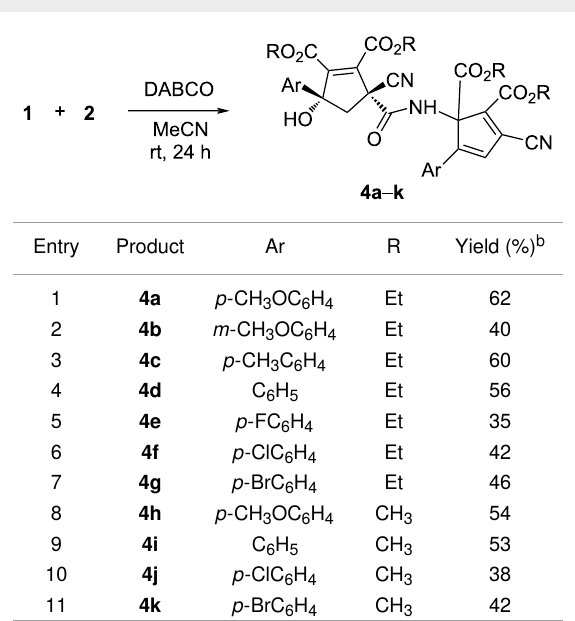
Table 3: Synthesis of compounds 4a – k .